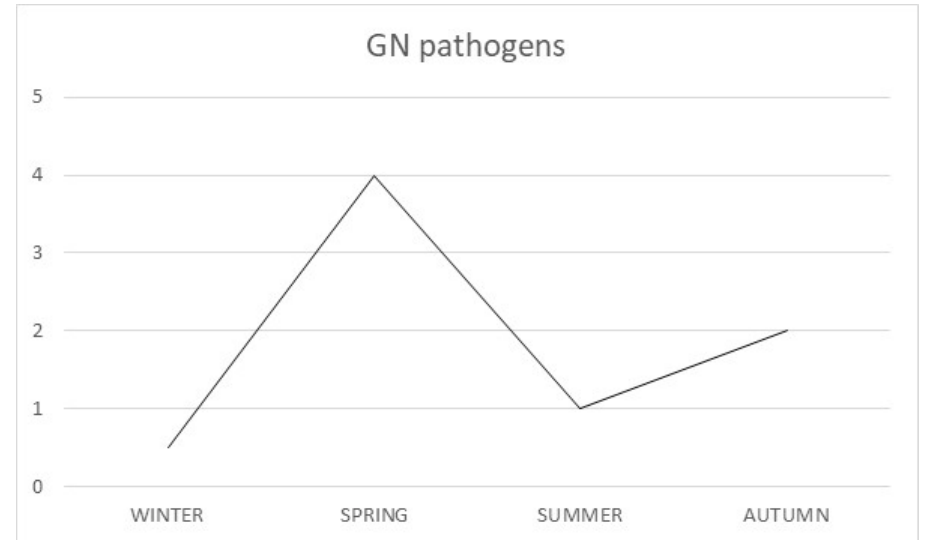
Figure 2. Seasonal variability of GN bacteria.